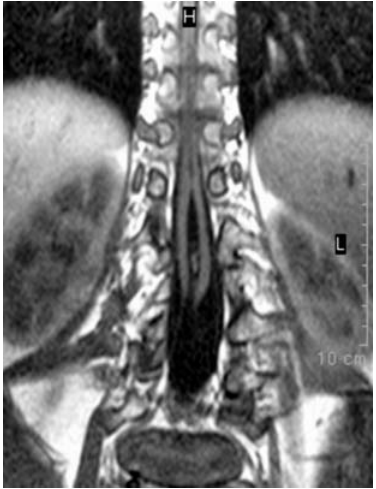
FIGURE 2. Coronal T1-weighted image shows diastematomyelia with intervening spur. Note that both hemicords have ended separately. Left sided L2-L3 laminar fusion was also